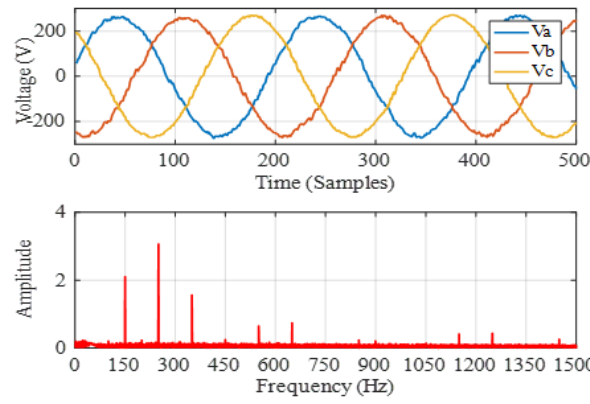
Fig. 6. Grid fed voltage and respective frequency